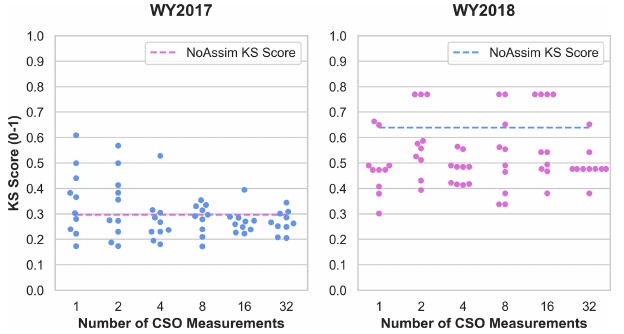
Figure 6. Swarm plots of Kolmogorov–Smirnov scores. The ensem- ble simulations are ranked by Kolmogorov–Smirnov (KS) score per year and plotted according to the number of measurements assimi- lated, including the no assimilation (NoAssim) case.